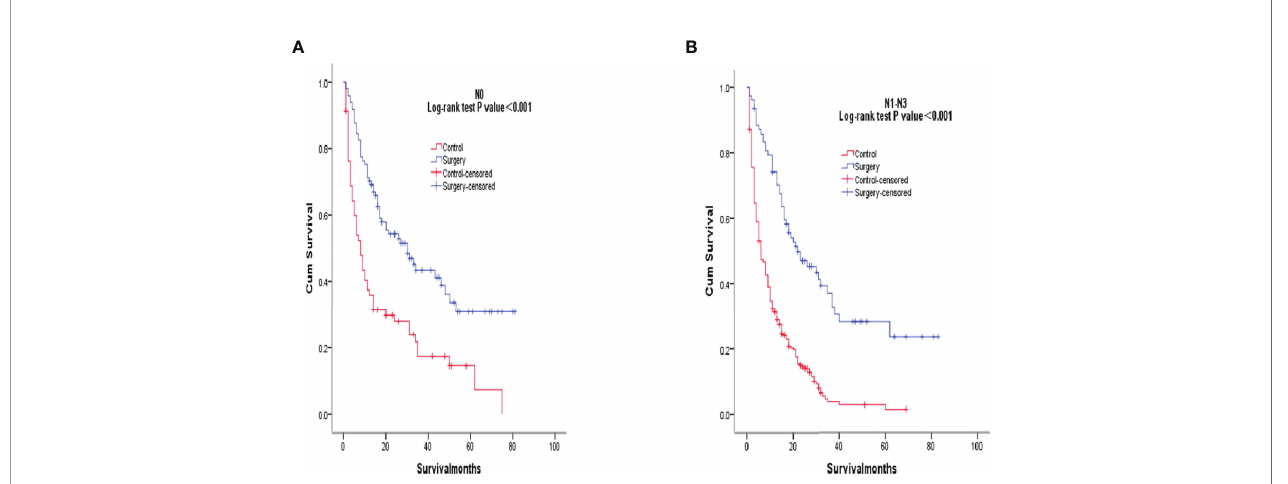
FIGURE 6 | Kaplan-Meier overall survival curves of surgery-treated patients vs control after propensity score matching strati fi ed by N0, (A) , N1-N3 (B)